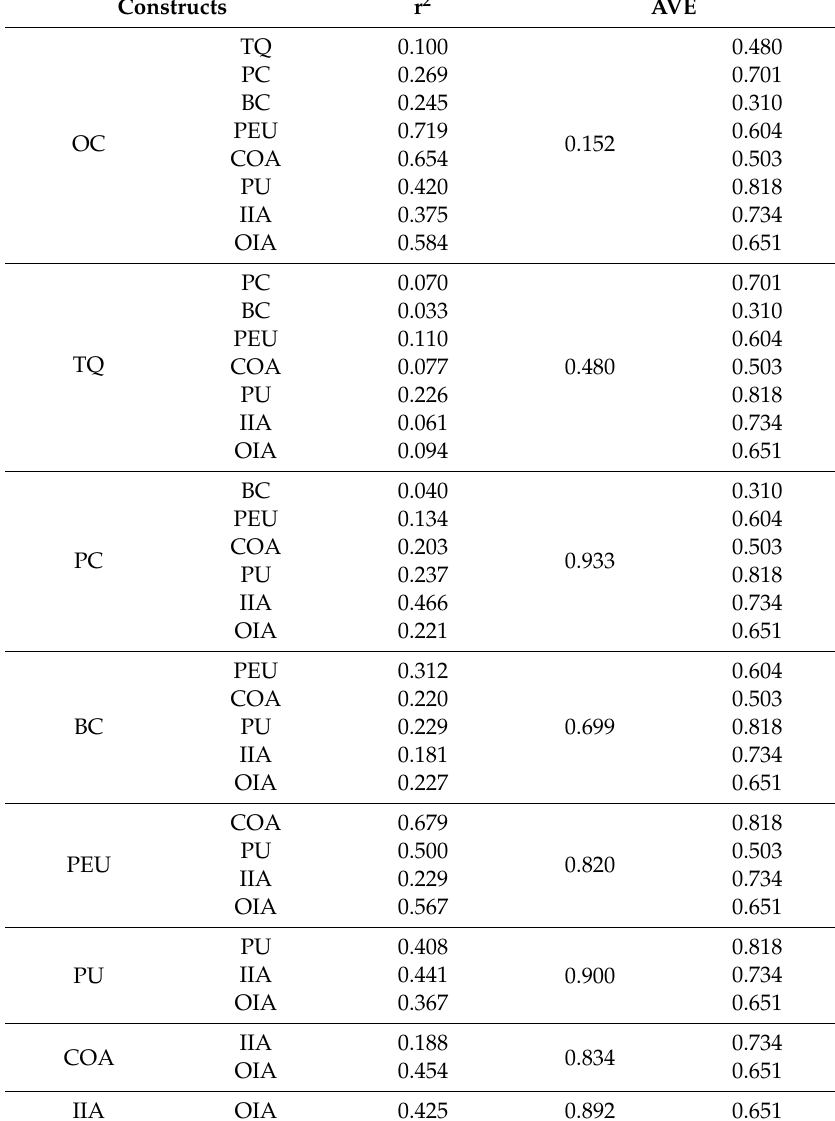
Table 4. Results of discriminant validity